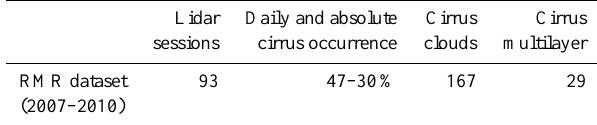
Table 2. Characteristics of cirrus data set for the period